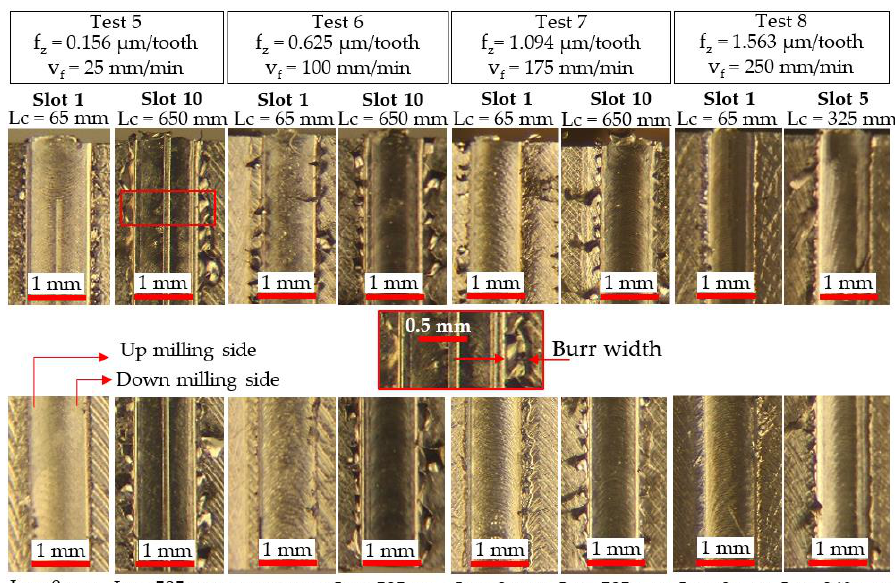
Figure 16. Optical micrographs of burr formation on the first and last slots machined using Ø 1 mm end-mills.